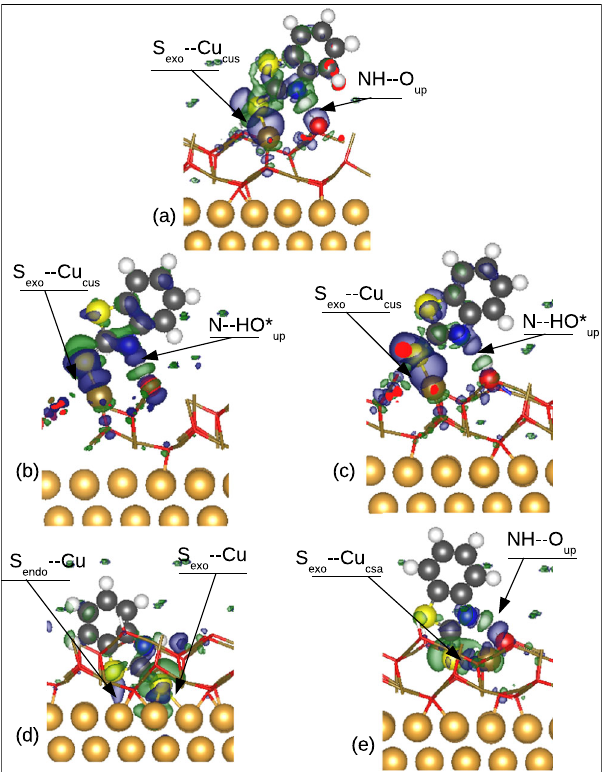
Fig. 9 Charge-density difference analysis for MBT° adsorbed on partially oxide-covered copper surface. a Snapshot on the oxide surface and oxide edges, b and c on the metal surface, and d and e on the oxide walls. Light blue and green colors of the isosurface correspond to accumulation and depletion of charge density,